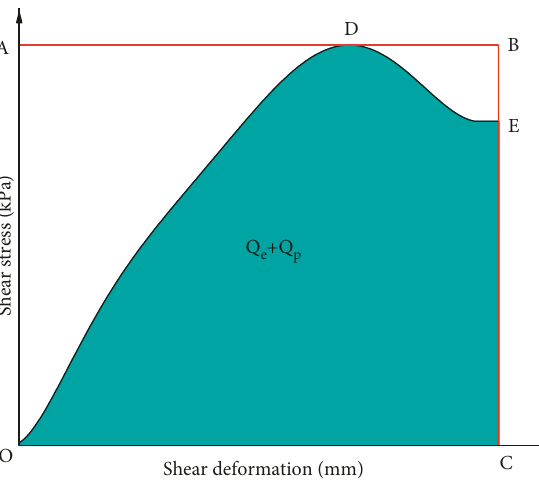
Figure 9: The shear strength of lunar soil simulant.